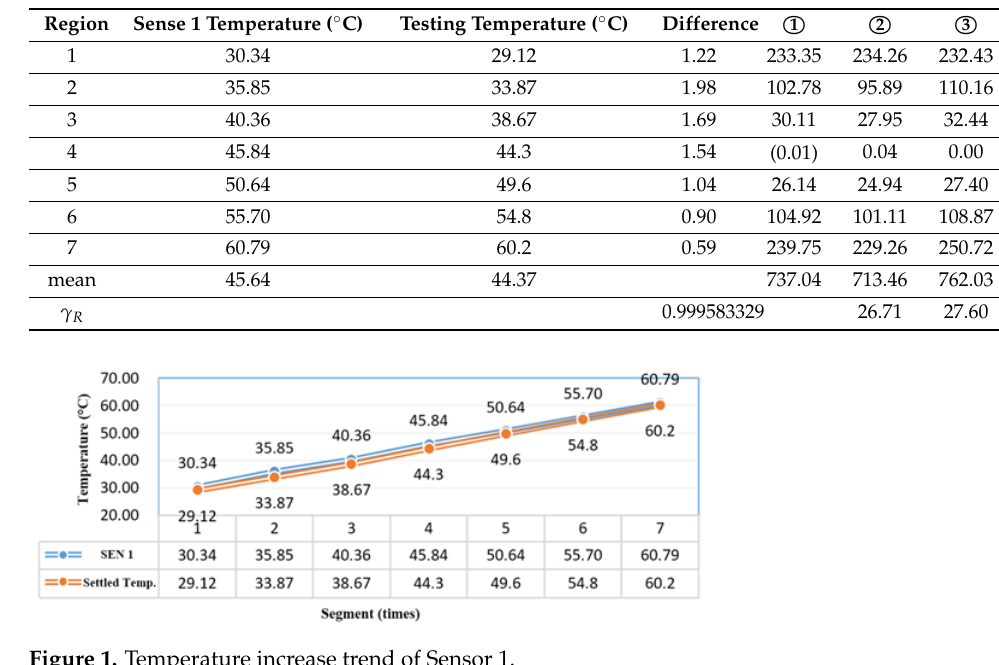
Table 2. Temperature interval data of Sensor 1.